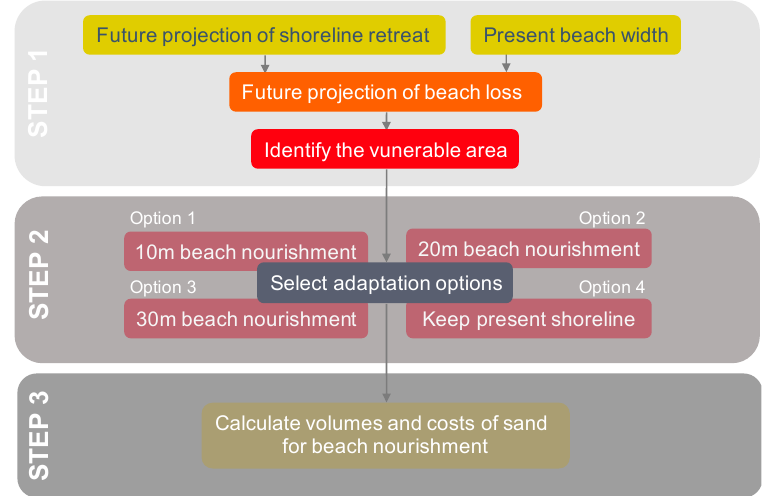
Figure 5. Framework for beach nourishment in Thailand adapted from Yoshida et al. [2].